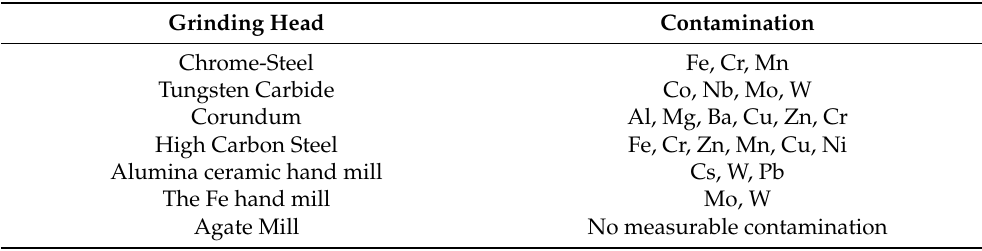
Table 5. Trace elemental contamination by different grinding heads during the rock sample powder- ing process [54–57]. Grinding Head Contamination Chrome-Steel Fe, Cr, Mn Tungsten